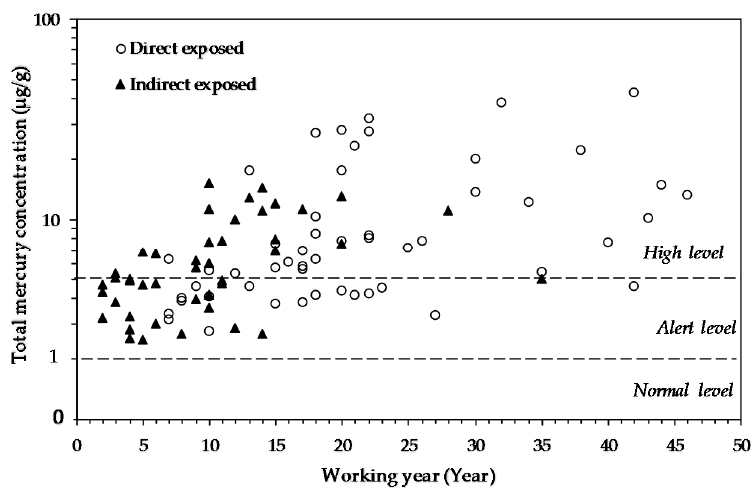
Figure 3. Relationships of working year and mercury concentration in the hair of directly- and indirectly-exposed groups.